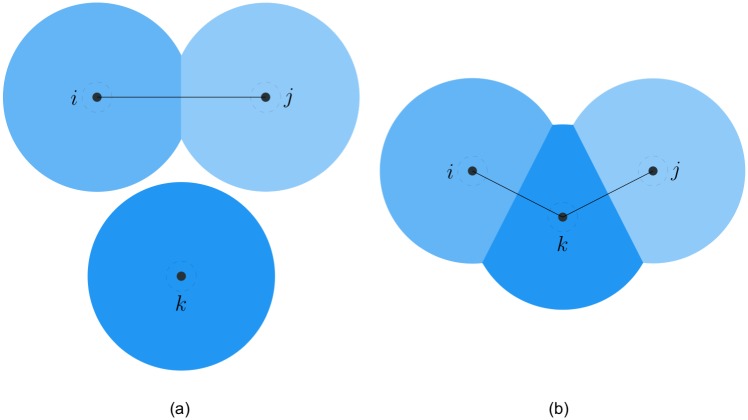
The first switching case.The case of replacing one existing link by two new links at the switching time. (a) before switching. (b) after switching.